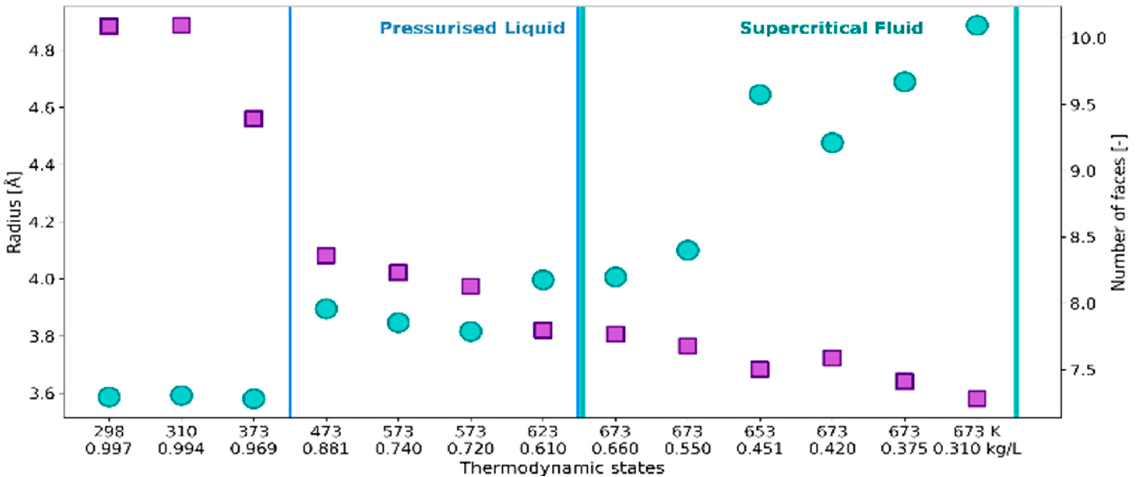
Figure 1. Cage radius R (circles, left axis) and the number of faces N F (squares, right axis) of VP representing solvation shell of • OH aq in the thermodynamic states defined by temperature and density as in Table 1.